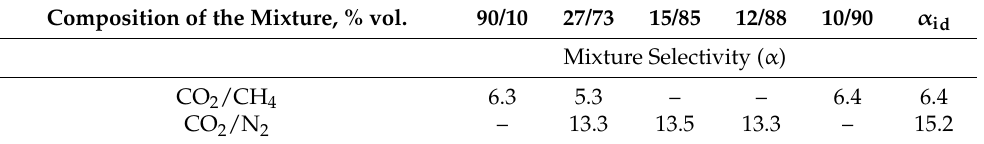
Table 7. Selectivity of separation of CO 2 /CH 4 and CO 2 /N 2 mixtures at 25 ◦ C. Composition of the Mixture, %